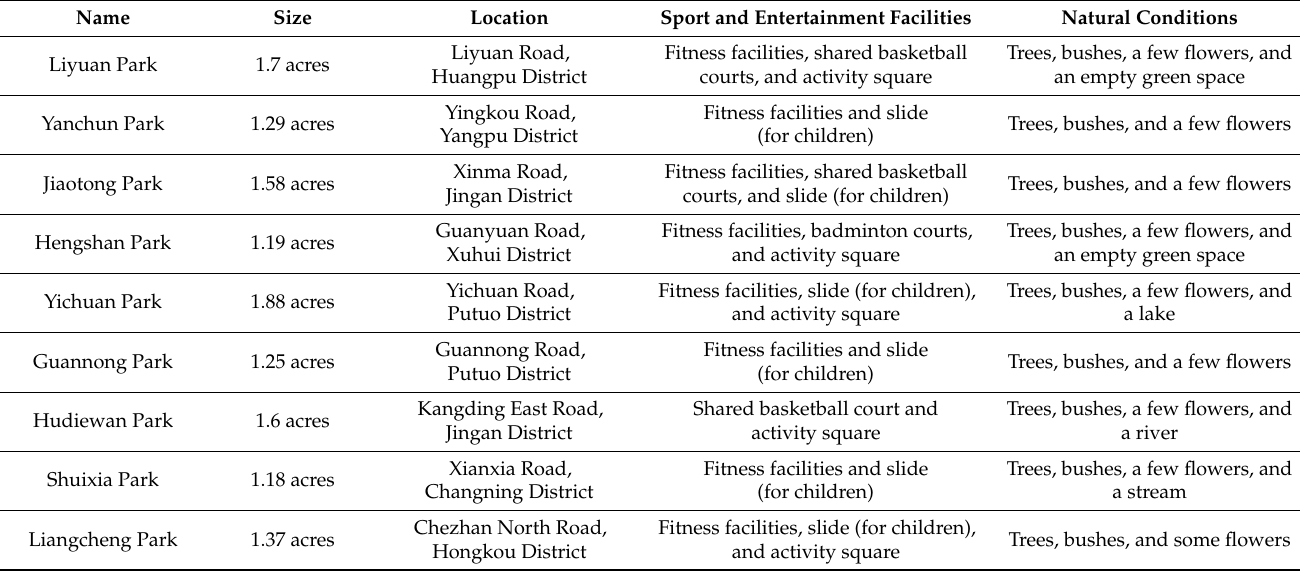
Table 1. The details of the nine